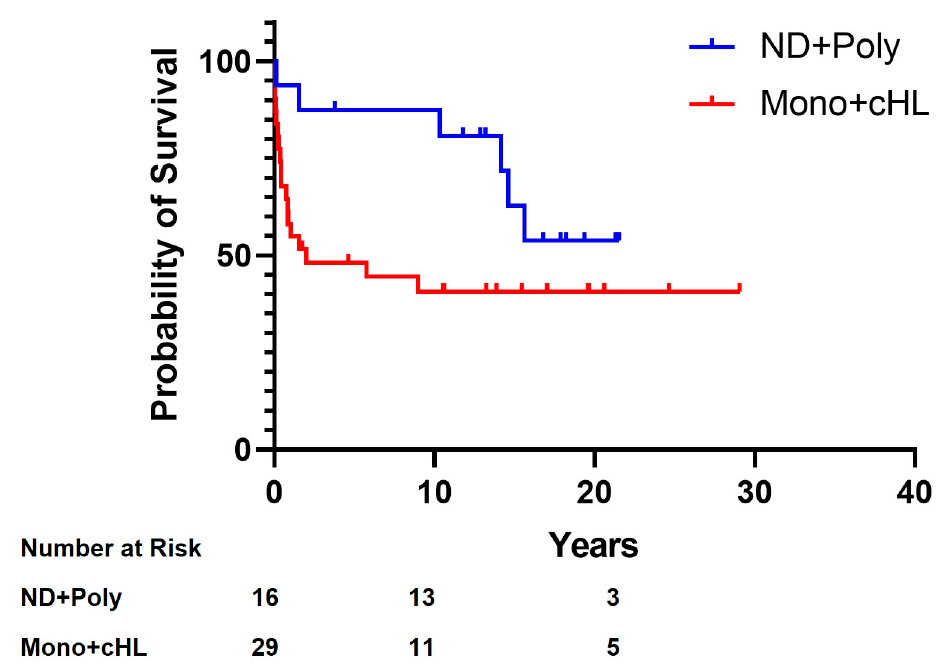
Figure 2. Overall survival by PTLD subtypes. ND: Non-destructive; Poly: Polymorphic; Mono: Monomorphic ( p = 0.021).